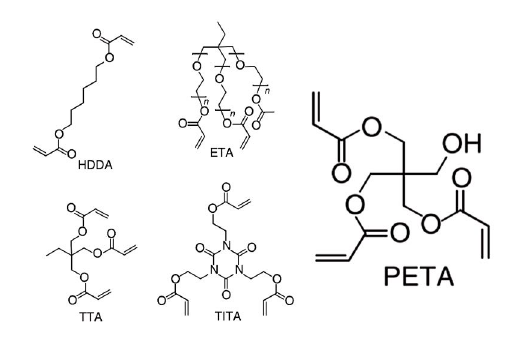
Figure 2. Common Monomers